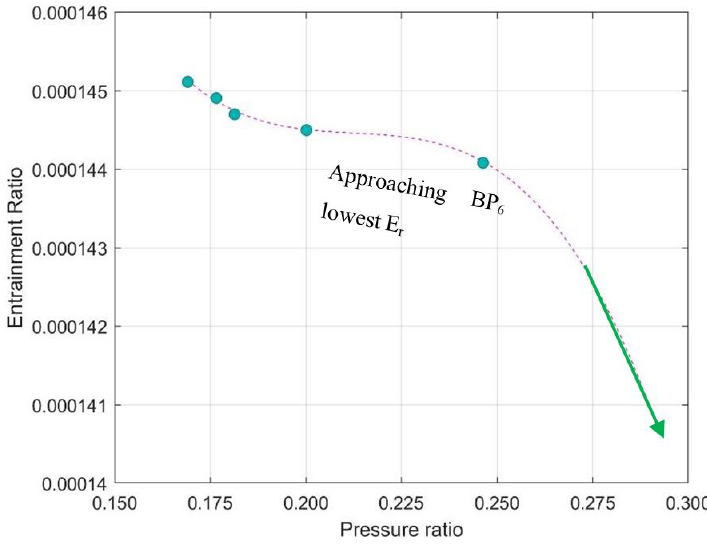
Figure 14. Entrainment ratio vs. Pressure ratio for